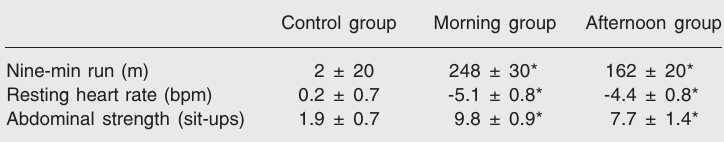
Table 2. Effect of morning and afternoon exercise by asthmatic children on the results of the exercise program.